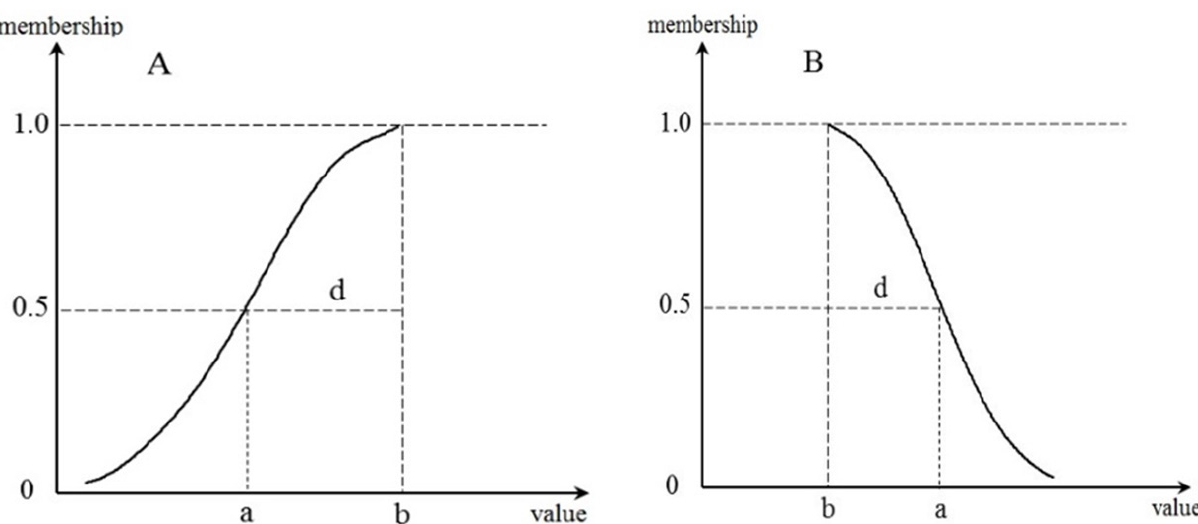
Figure 2. The fuzzy logic models. ( A ) and ( B ) represent the positive and negative indicators, respectively.